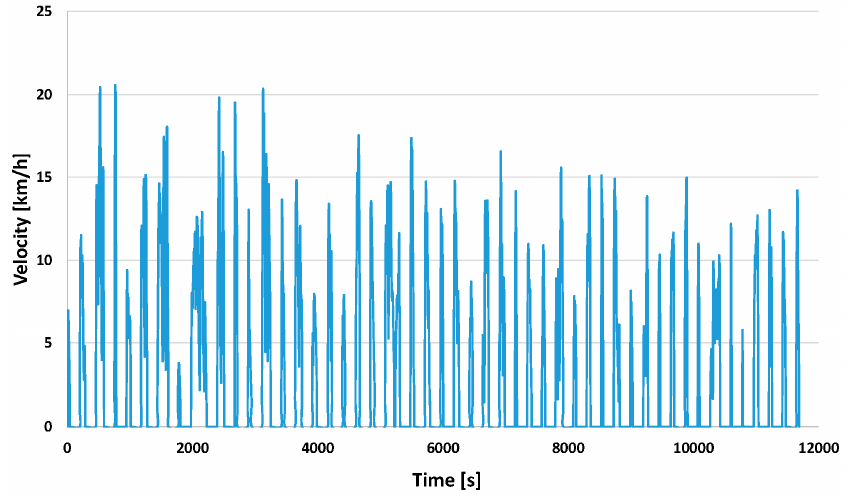
Figure 14. Complete Speed Profile (route 1 and route 2).